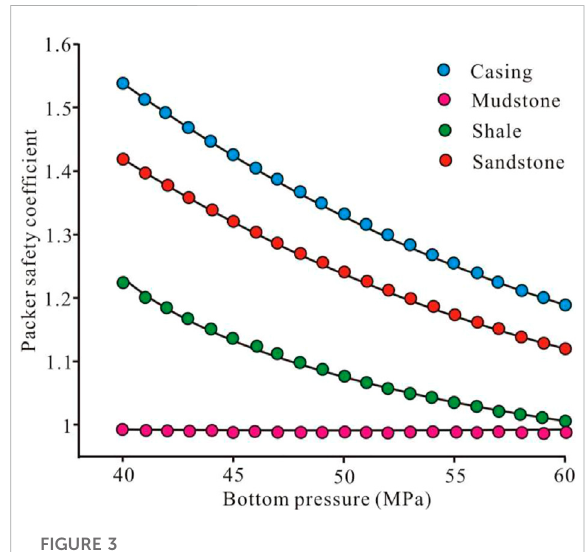
FIGURE 3 Relationship between the isolation safety factor and the pressure under the rubber